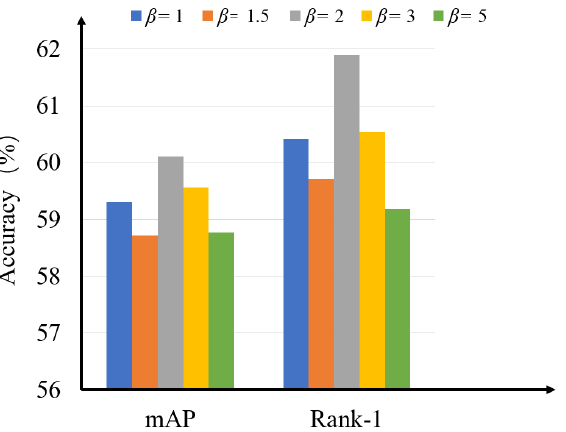
Figure 4. The influence of the hyperparameter β in mAP accuracy and Rank-1 accuracy.